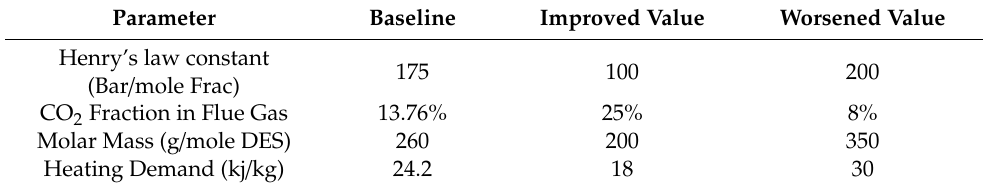
Table 2. Sensitivity analysis parameters; using ChCl at 10% CO 2 removal, 20,000 kmoles DES / hour.